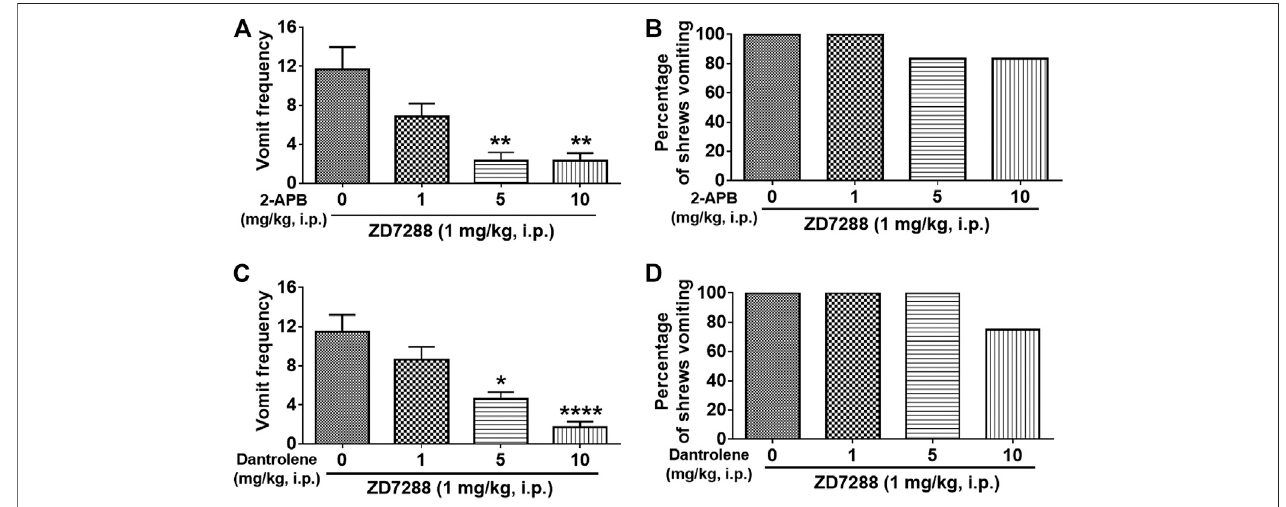
FIGURE 11 | Effects of intracellular Ca 2+ channel modulators on the HCN channel blocker ZD7288-induced emesis. Thirty minutes prior to an injection of ZD7288 (1 mg/kg, i. p.), different groups of least shrews were given an injection (i.p.) of either the corresponding vehicle, or varying doses of: 1) the ryanodine receptor (RyR) antagonist dantrolene ( n (cid:2) 8 shrews per group) (A, B) , and 2) the inositol-1, 4, 5-triphosphate receptor IP 3 R antagonist 2-APB ( n (cid:2) 6) (C, D) . Emetic parameters were recordedforthenext30 minpostZD8288injection. (A,C) ThefrequencyofemesiswasanalyzedwithKruskal-Wallisnon-parametricone-wayANOVAfollowedby Dunnett ’ s post hoc test and presented as mean ± SEM. (B, D) Percentage of shrews vomiting was analyzed with chi-square test and presented as mean. * p < 0.05, ** p < 0.01, **** p < 0.0001 vs. 0